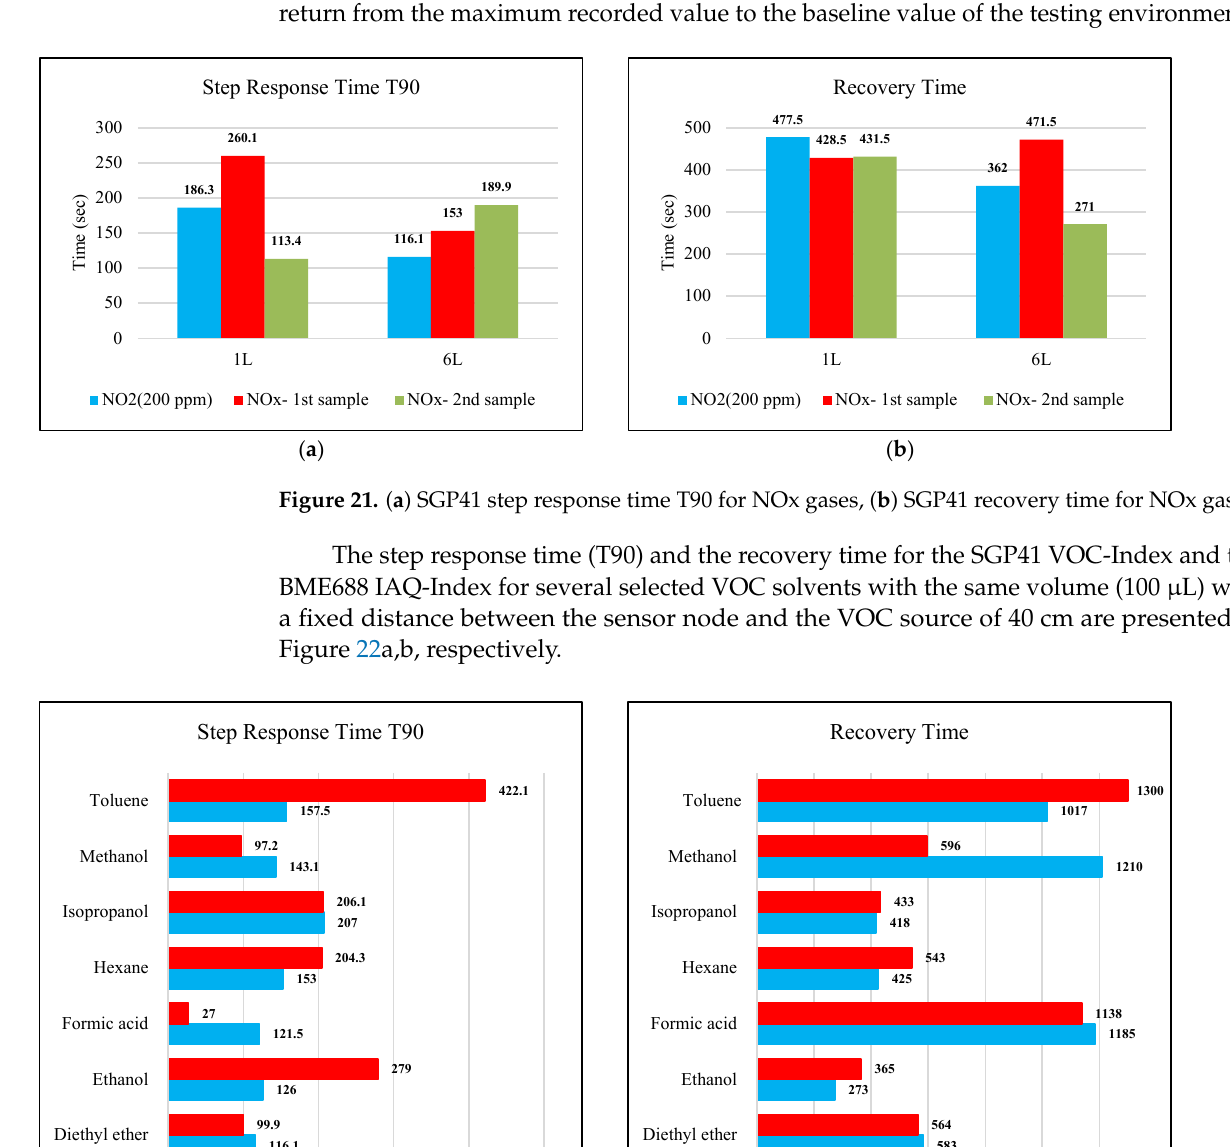
( d ) Figure 20. Test results for toluene: ( a ) BME688 40 cm, ( b ) SGP41 40 cm, ( c ) BME688 100 cm, ( d ) SGP41 100 cm.